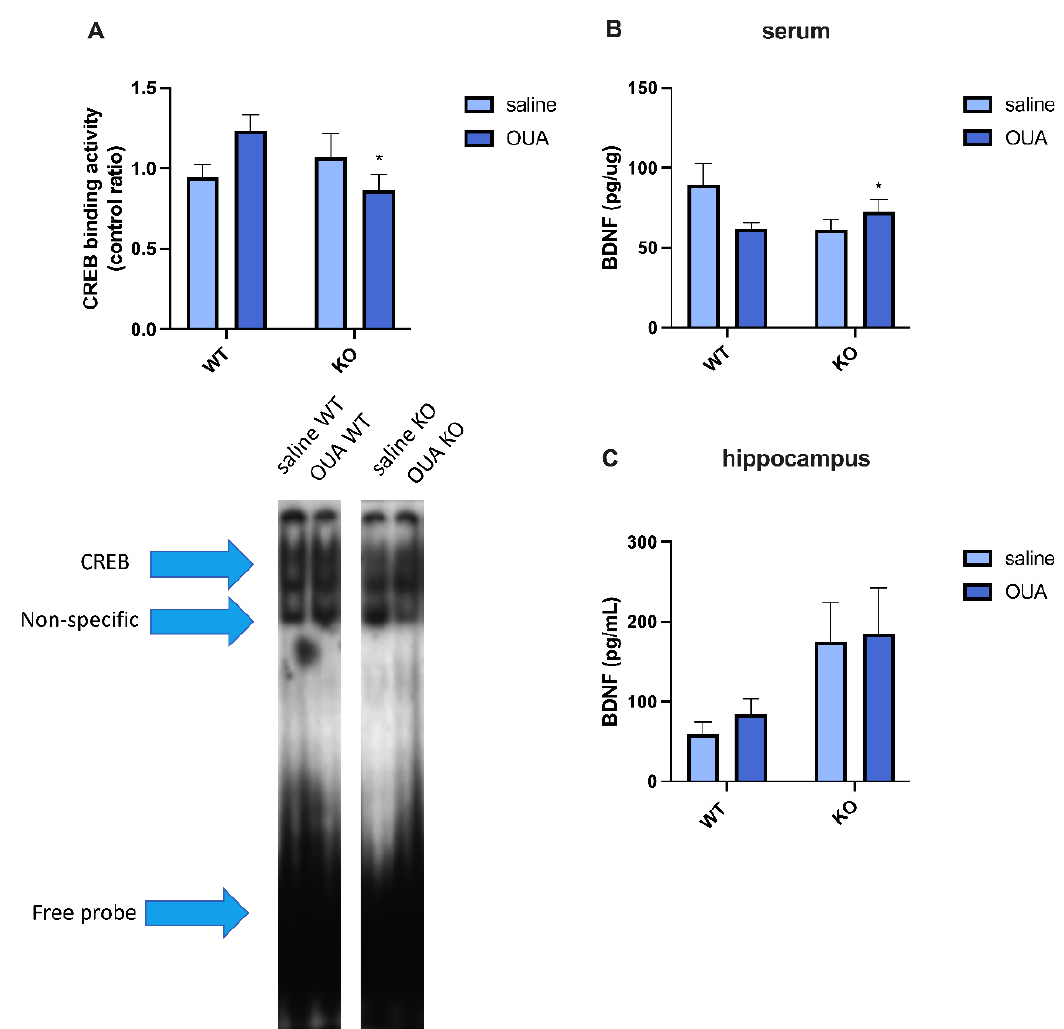
Figure 3. CREB activity and BDNF levels in the hippocampus and serum. ( A ) Densitometric analysis and representative EMSA of CREB binding activity showed an interaction between gene and treatment [F (1, 15) = 4987, (* p < 0.05)], the same interaction was seen in ( B ) for BDNF levels in the hippocampus [F (1, 16) = 4541, (* p < 0.05)]. ( C ) Levels of BNDF in serum are higher for gene factor [F (1, 18) = 7511]. Results are expressed in a ratio form control for CREB activity ( n = 4, N = 2) and pg/ υ g (mean ± SEM) for hippocampal BDNF levels ( n = 4, N = 2) and or pg/mL (mean ± SEM) for BDNF serum levels ( n = 5, N = 2). The samples were analyzed by two-way ANOVA, followed by Tukey´s post-test.